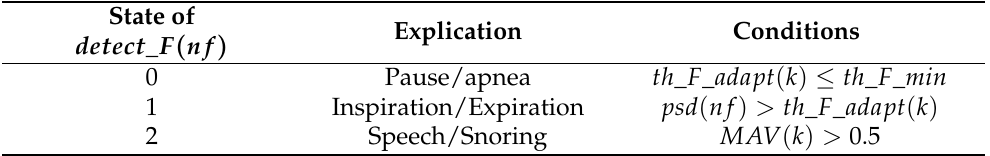
Table 2. Frequency detection